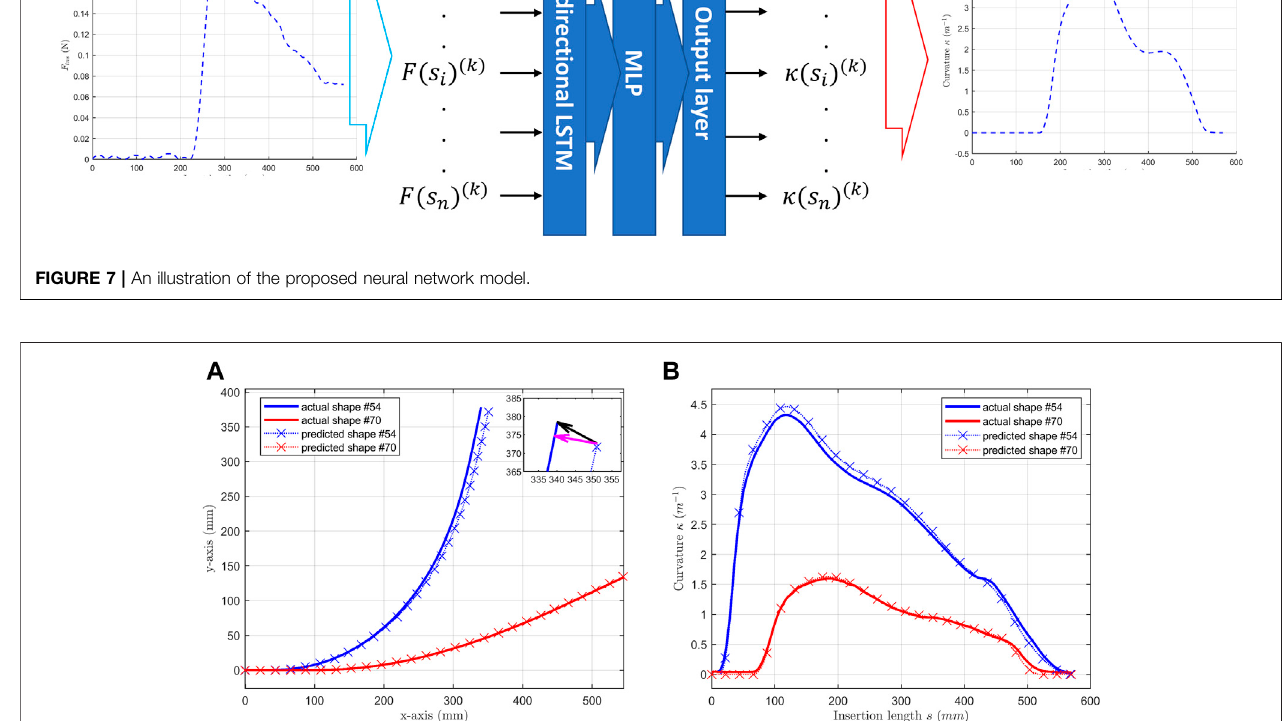
FIGURE 8 | Selected shapes (shape #54 & #70) predicted by the NN model with bidirectional LSTM. (A) predicted shapes are compared with actual shapes; (B) predicted curvatures are compared with actual curvatures.